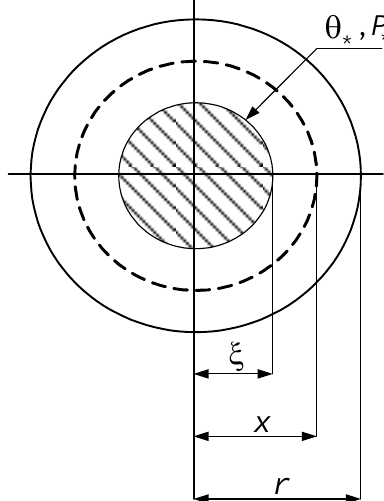
Figure 1. The physical model of the localized evaporation front in the pellet, where ξ is the radius of the evaporation front and x is the radial coordinate of the pellet.